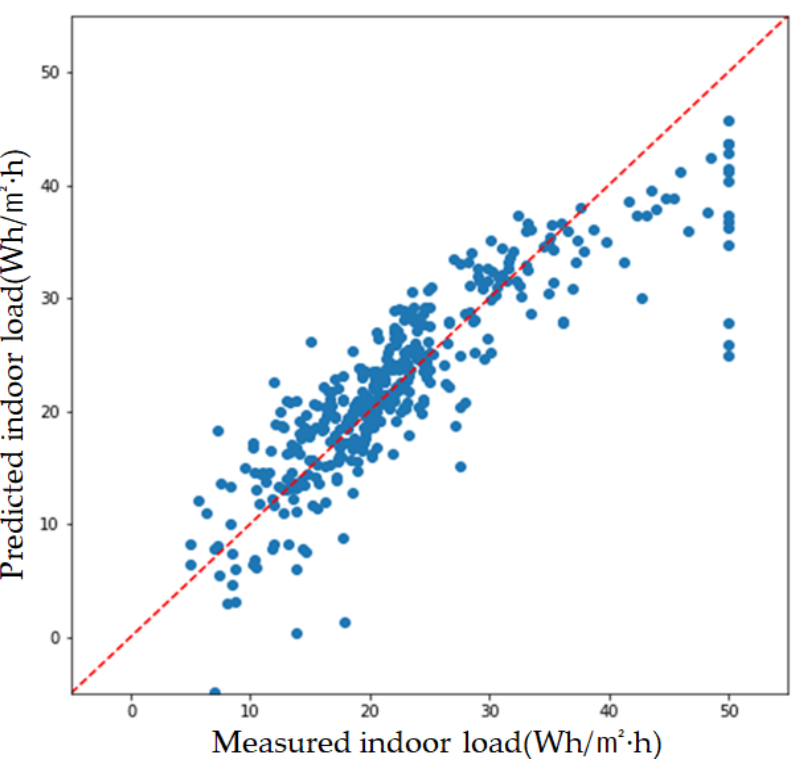
12 of 15 Table 7. Significance test for the energy consumption prediction algorithm. Regression Coefficient (Coef) Standard Deviation (Std Err) Significance Level ( p -Value > |t|) Number of occupants (predicted)